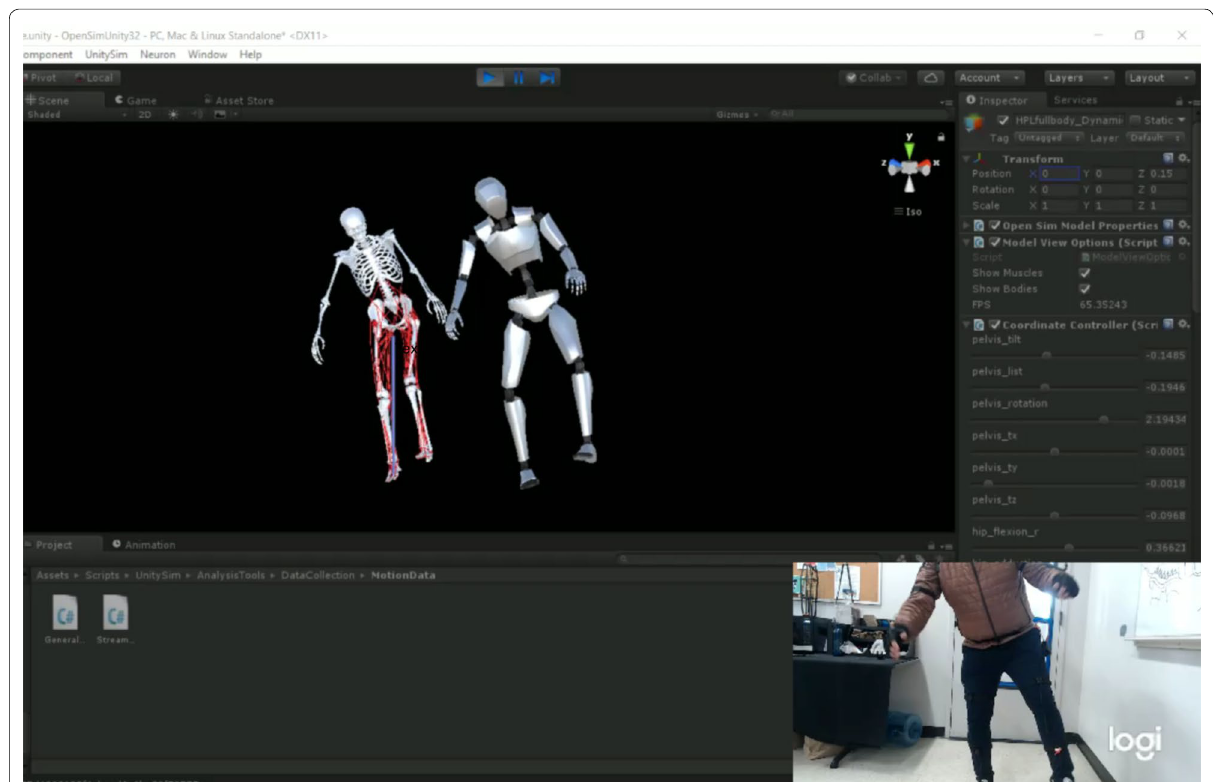
Fig. 1 Motion tracking and reconstruction in our framework. The blue line illustrates the ground reaction forces during single leg balancing